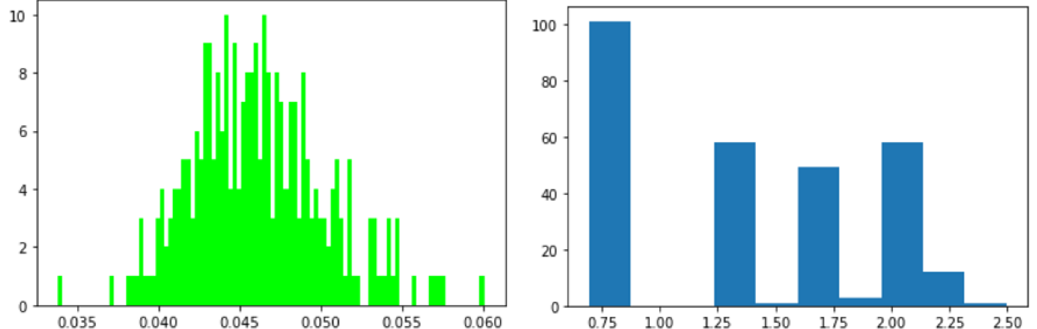
Figure 7 . Left : histogram plot with 100 bins generated by the maximum entropy of the principal axes of 282 random g s with respect to the C 2 ⊗ C 2 ⊗ C 2 decomposition in su (8) . Notice how the scaling on the x -axis is about twice the partial decomposition plot in figures 6, which is the result of adding the entropy of two partial decompositions 2 × 4 and 4 × 2 . Right : 10 bins histogram plot of the maximum entropy of principal axes of g in the 282 solutions of su (8) w.r.t. the same